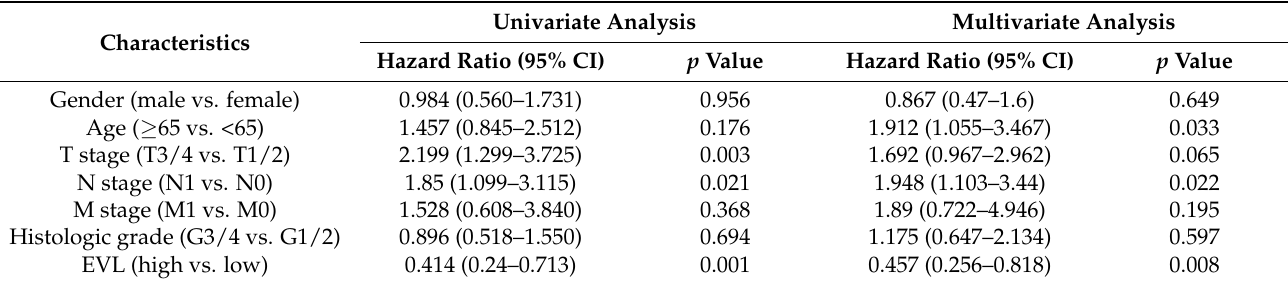
Table 3. Univariate and multivariate Cox regression